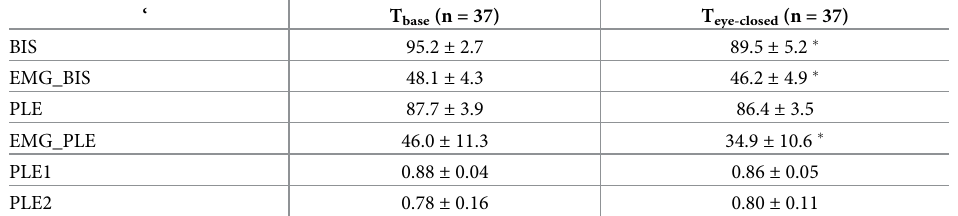
Table 2. During induction of anesthesia, propofol Ce at LOC was 3.5 ± 0.6 μ g/ml in 37 patients. The BIS, EMG_BIS, PLE, EMG_PLE, PLE1, and PLE2 decreased significantly at all time points compared to T0 (P < 0.05) while propofol Ce at LOC was maintained for 3 min. The BIS, EMG_BIS, PLE, EMG_PLE and PLE1, but not PLE2, decreased significantly for 3 min (P < 0.05) (Table 3). Mean blood pressure decreased significantly at all time points compared to T0 (T0: 82.1 ± 10.9 mmHg, T1: 74.9 ± 12.4 mmHg, T2: 73.4 ± 11.3 mmHg, T3: 72.5 ± 13.7 mmHg, P < 0.05). Heart rate decreased significantly only at T3 compared to T0 (T0: 69.2 ± 10.4 /min, T1: 67.8 ± 9.9/ min, T2: 67.2 ± 10.0 /min, T3: 66.0 ± 9.3 /min, P < 0.05). We Table 1. Changes before and after closing eyes.